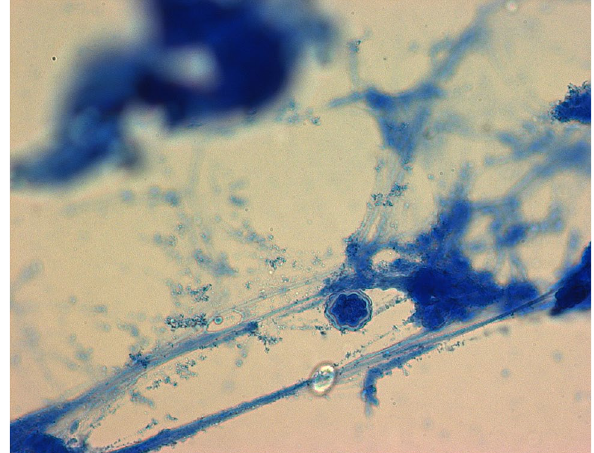
Figure 1. Acanthamoeba cyst.